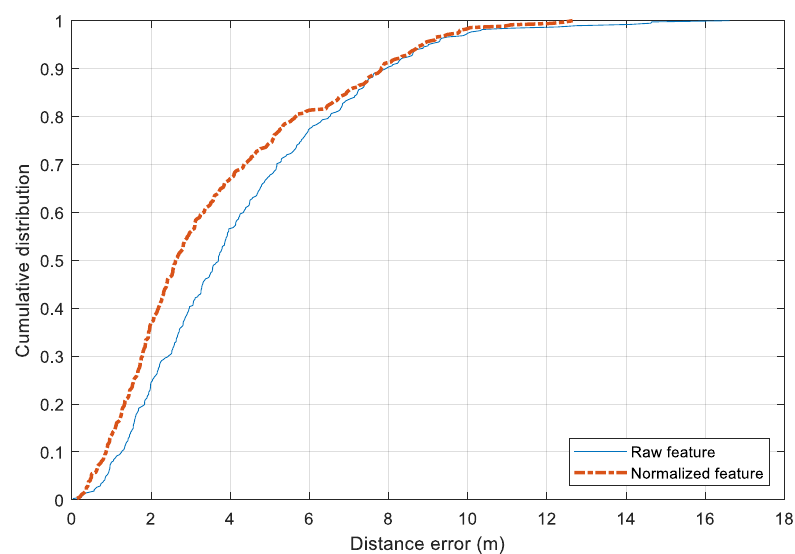
Figure 11. Comparison between the raw feature and the normalized feature in training with Random Forest model.